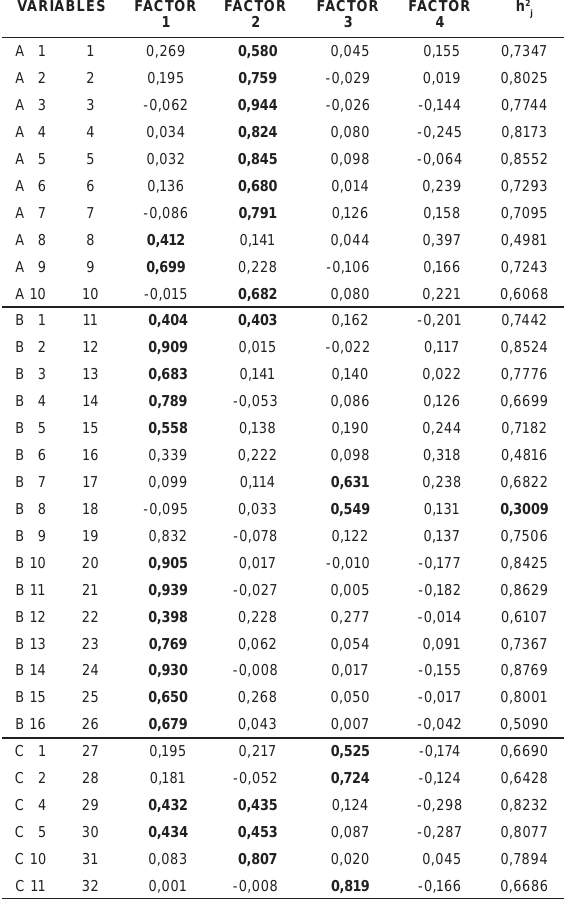
TAbLE 17 Rotated factor matrix (direct oblimin) shortened